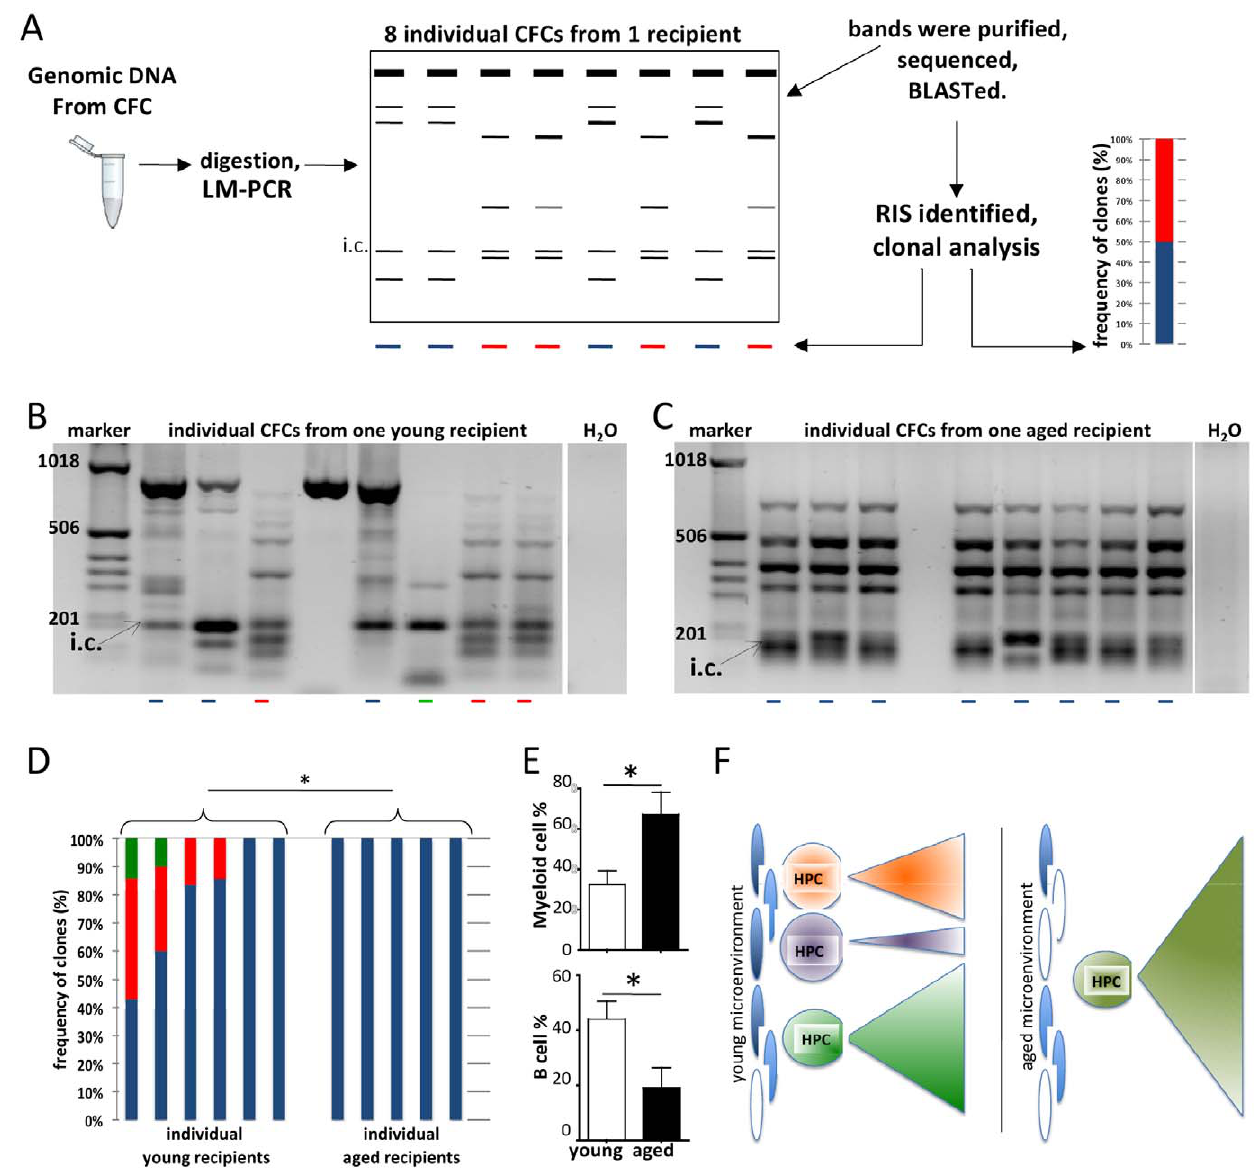
Figure 2. Coexistence of balanced HSC populations is characteristic for young microenvironment whereas an aged microenvironment favors the expansion of single dominant hematopoietic clone. ( A ) Schematic representation of the retroviral insertional mutagenesis screen. DNA was extracted from individual CFCs (average: 7.3 6 1.8 GFP + CFCs/mouse were isolated) and digested with four- cutter enzymes. After LM-PCR, the recovered bands were isolated and sequenced. The sequences were aligned to the mouse genome with NCBI/ BLAST program. The RISs were identified and the closest genes (within a 6 100 kb window) were listed. Based on the LM-PCR band-pattern and the identified RISs, clonal analyses were performed. ( B ) Representative agarose gel analysis of LM-PCR performed on methylcellulose colonies isolated from BM of one representative young transplanted mouse. Clonality was identified based on the band pattern and DNA sequence information on individual bands. Distinct colors represent distinct clones. ( C ) Insertion sites recovered by LM-PCR from CFCs of one representative aged recipient mouse. The red arrows depict distinct GFP peaks. i.c.: internal control bands represent PCR products amplified from the viral genome. ( D ) Distribution of clonality within the GFP + CFC population of young and aged recipient mice determined by the LM-PCR pattern and sequence information. ( E ) Flow cytometric analyses of PB of young and aged recipient mice (same mice were used in clonal analysis and RISs identification). Myeloid cells were identified based on Gr1 and Mac1 expression and B220 was used as B cell marker. (young mice n=6, aged mice n=5, from 3 independent experiments), *=p , 0.05 ( F ) Proposed model for clonality of hematopoiesis in young and aged microenvironment. doi:10.1371/journal.pone.0042080.g002 to least 10% of the transduced population (Figure 2D), while All animals transplanted in this study remained leukemia-free at least up to 6 month post-transplantation as indicated by normal the restriction enzyme used for LM-PCR analysis will cover at least 85% of all possible integration sites [20], implying that the spleen weight (Figure S1) and normal PB white blood cell counts observed mono-clonality in CFC colonies might represent in (data not shown) in both age, supporting that the frequency of a good number of cases true monoclonality in vivo. malignant transformation in response to transduction with SF91 is